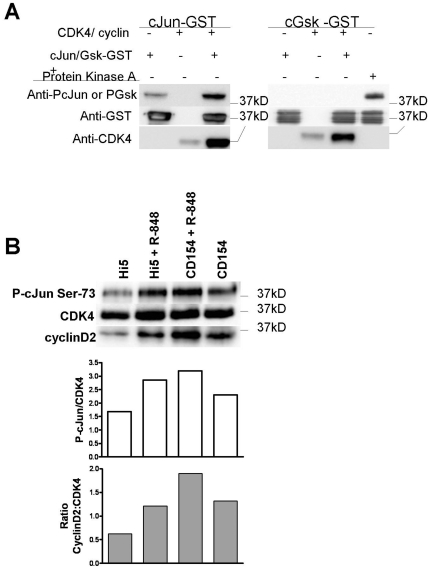
Phosphorylation of cJun by cellular CDK4.A) Purified recombinant CDK4:cyclinD complex was reacted with cJun and
GSK GST fusion proteins to determine specificity of phosphorylation by
CDK4. Western blotting with phospho-specific Abs was used to monitor the
phosphorylation of the GST-fusion proteins. These data are
representative of 3 separate experiments. B) CDK4 was immunoprecipitated
from differentially stimulated B lymphocytes and reacted with GST-cJun
fusion protein as described in Methods. The presence of cyclin D2 and phosphorylation of
c-Jun was analyzed by Western Blot using anti-Ser 73 phospho-cJun Abs.
Blotting against CDK4 was used as a loading control. Quantitative
analysis of chemiluminescent band development enabled comparison of
relative protein amounts between treatments (bar graphs). These data are
representative of 2 separate experiments.